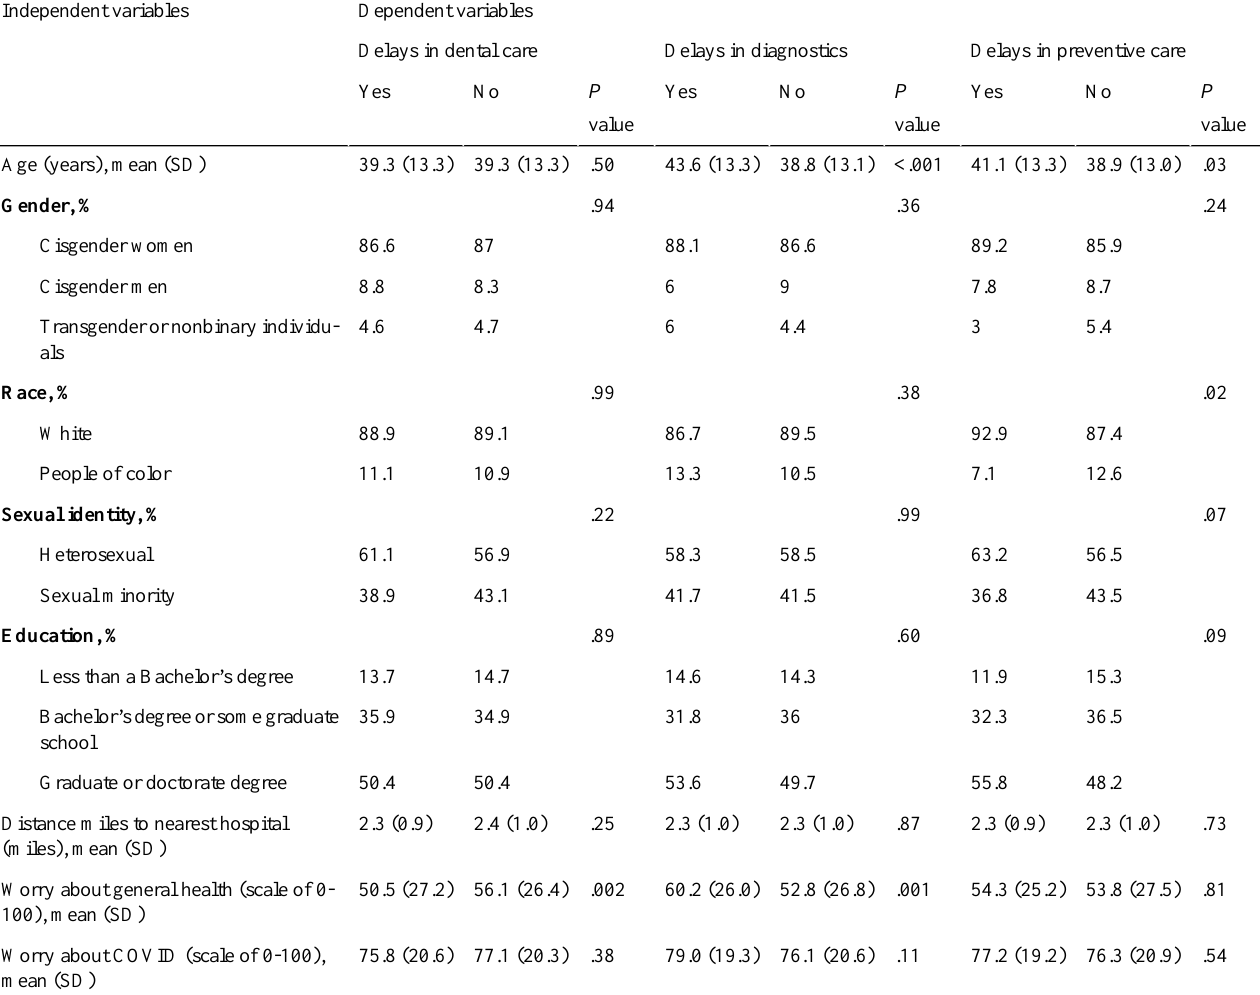
Table 4. Bivariate analyses of the reasons for experiencing health care delays resulting from the COVID-19 pandemic among those who reported experiencing any health care delays